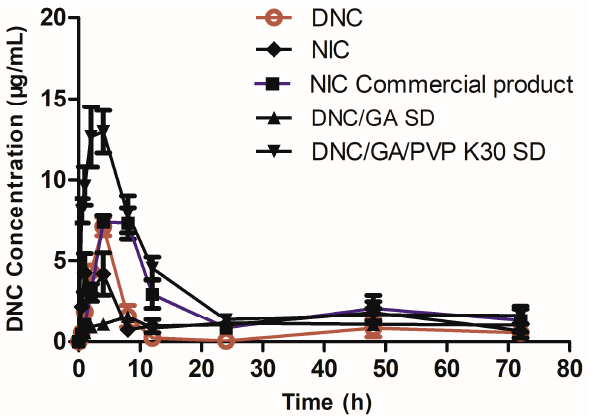
Figure 11. The cumulative penetration of DNC, DNC/GA SD, and